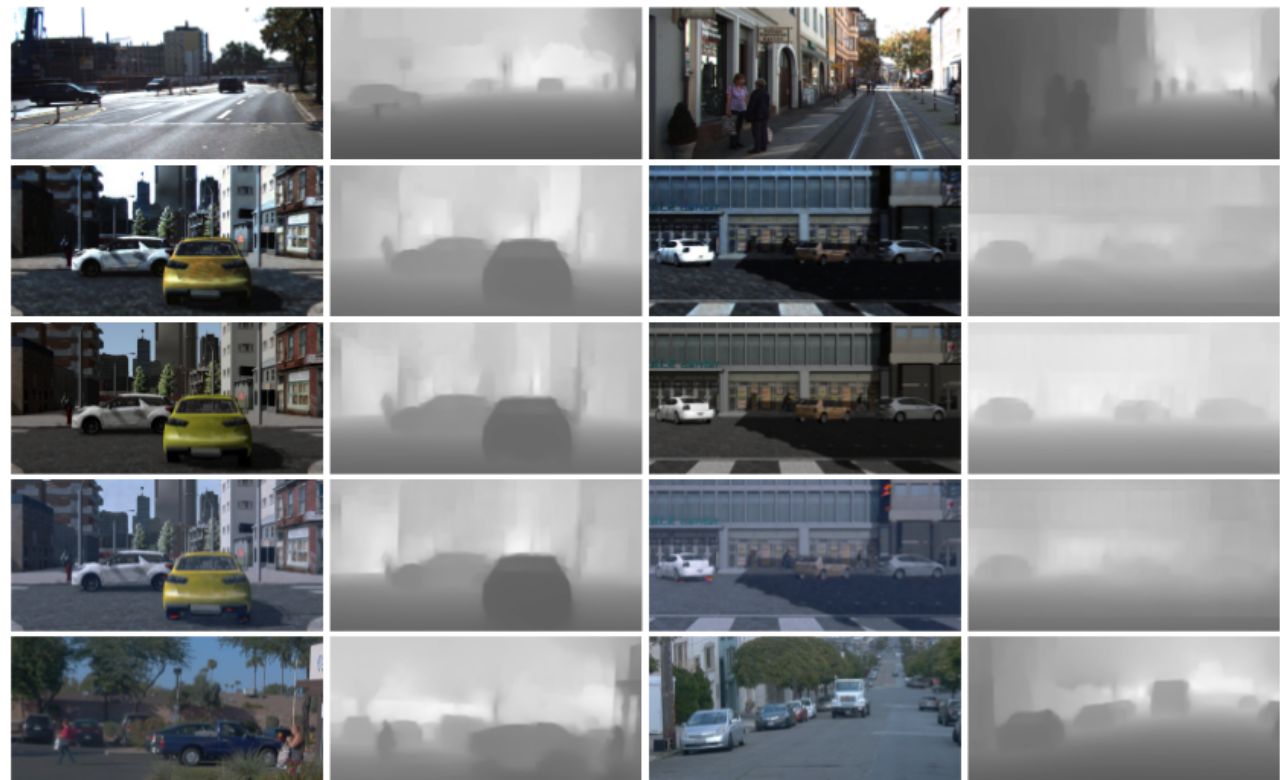
Figure 3. RGB images with their estimated depth. From top to bottom rows: samples from K , V G of V G and V G correspond to transforming the samples of V to K and W domains, respectively. The monocular depth K W estimation model [18] was trained on the K